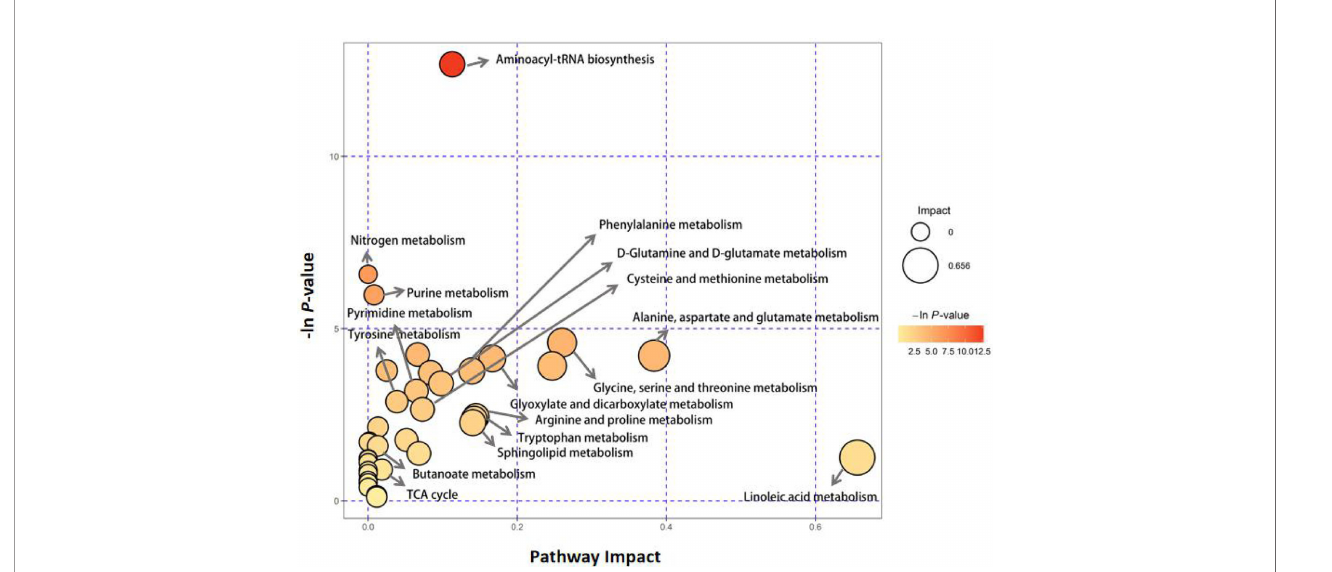
FIGURE 1 | Pathway analysis of serum metabolite pro fi les of the hyperthyroidism group compared to the control